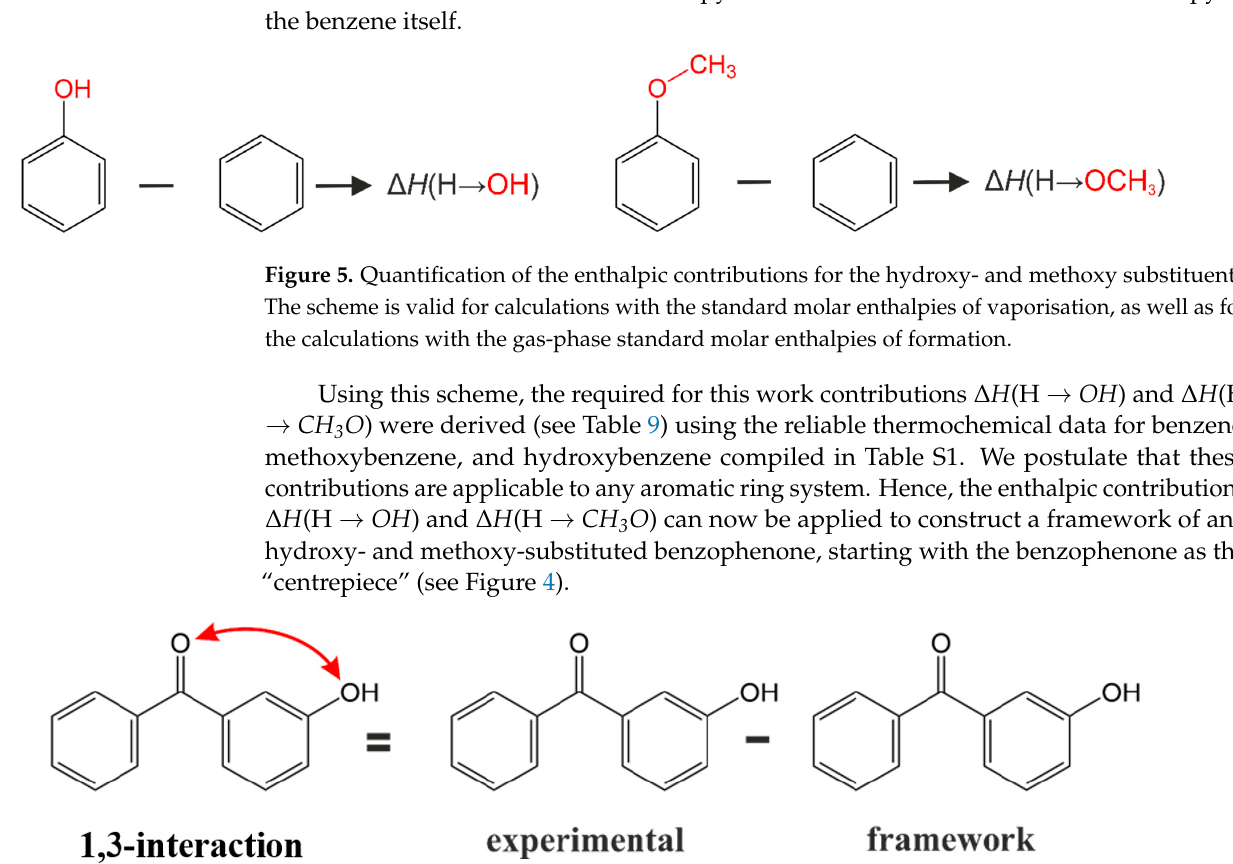
Figure 6. Example for a quantification of the 1,3 ‐ non ‐ nearest neighbour interactions of the carbonyl ‐ group with the OH substituent in 3 ‐ hydroxy ‐ benzophenone. The scheme applies both to the calculation of the standard molar enthalpies of vaporisation, and to the calculation of the standard molar enthalpies of formation in the gas ‐ phase.